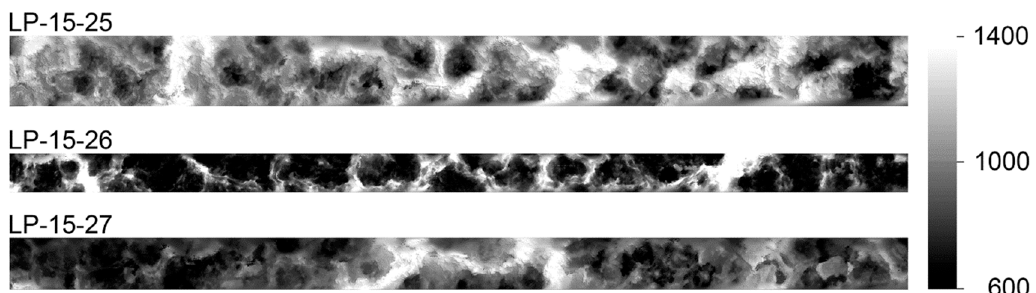
Figure 7. DEMs of LP-15-25, LP-15-26, and LP-15-27. It was predicted that the surfaces would be like